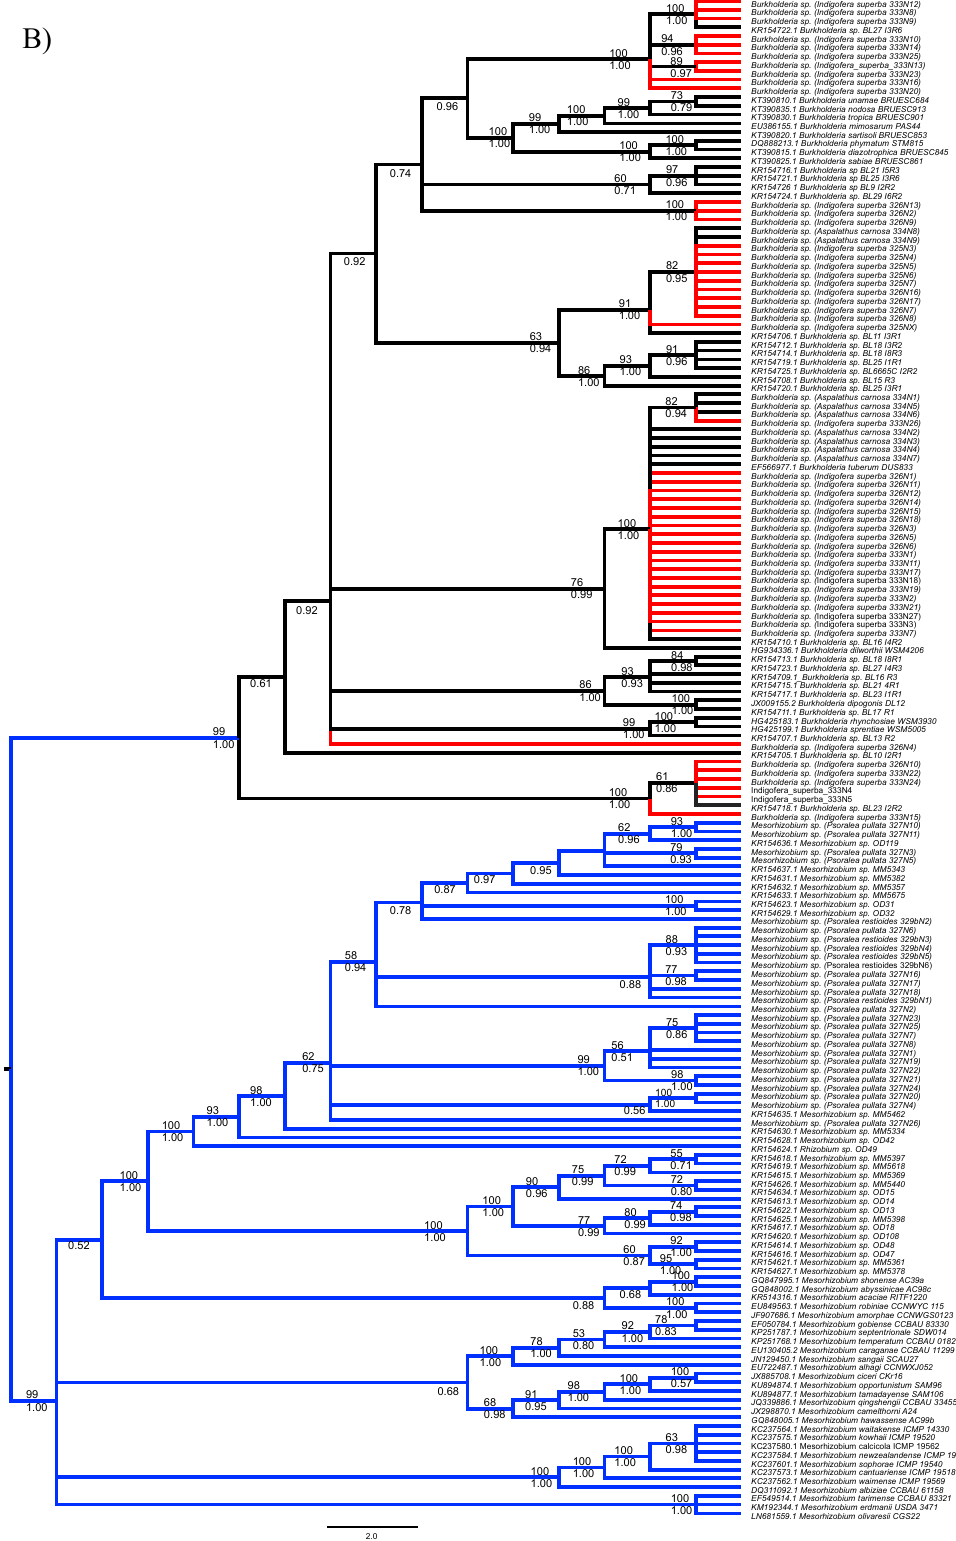
Figure 6. ( A ) Phylogenetic relationships of rhizobial strains based on nodC data, showing the phylogenetic position of strains isolated from I. superba (red nodes) in relation to rhizobial strains of other legumes in the CCR, blue: Mesorhizobium strains; and black: Burkholderia strains. ( B ) Detailed version of Figure 6A), showing the tip labels and ML and Bootstrap support values (%) above branches and Bayesian posterior probabilities below branches.